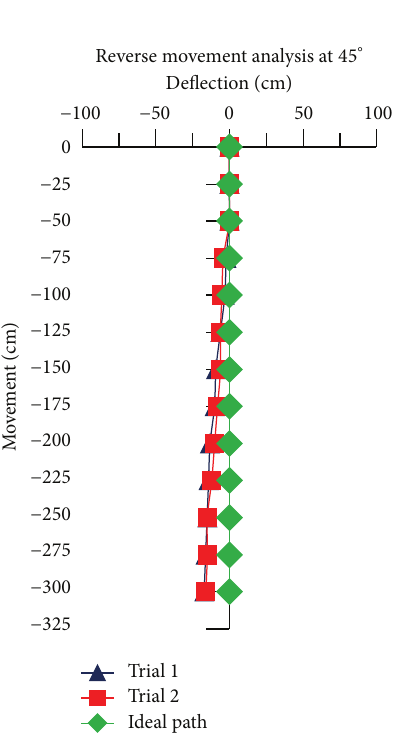
Figure 18: Reverse movement versus deflections at 𝜃 = 45 ∘ .